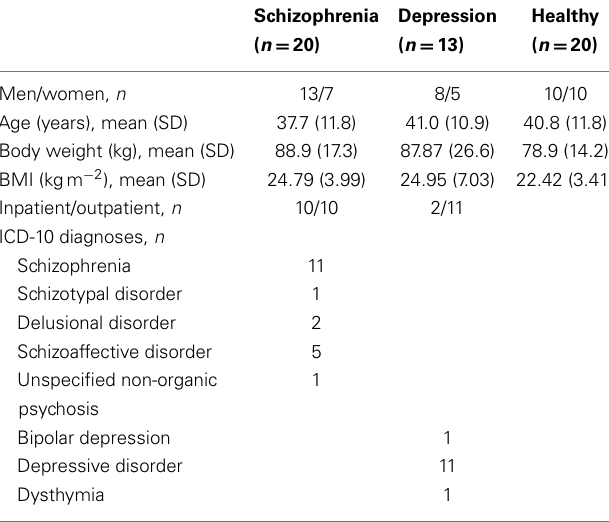
Table 1 | Characteristics of the subjects